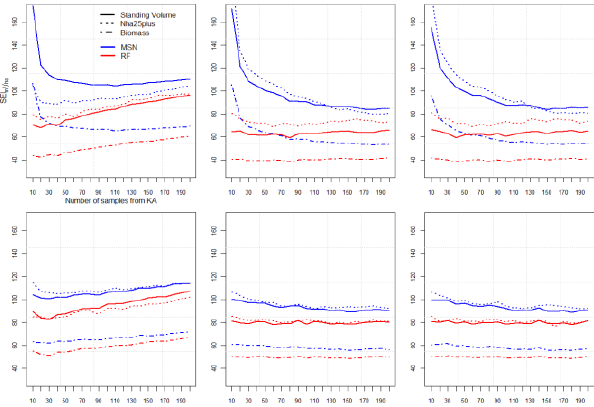
Fig.4. Absolute SEI of NN predictions for all combinations for single NN. Rows show values using all descriptors (a) and pruned descriptors (b). In each row, from left to right: random, stratified random and systematic stratified samples